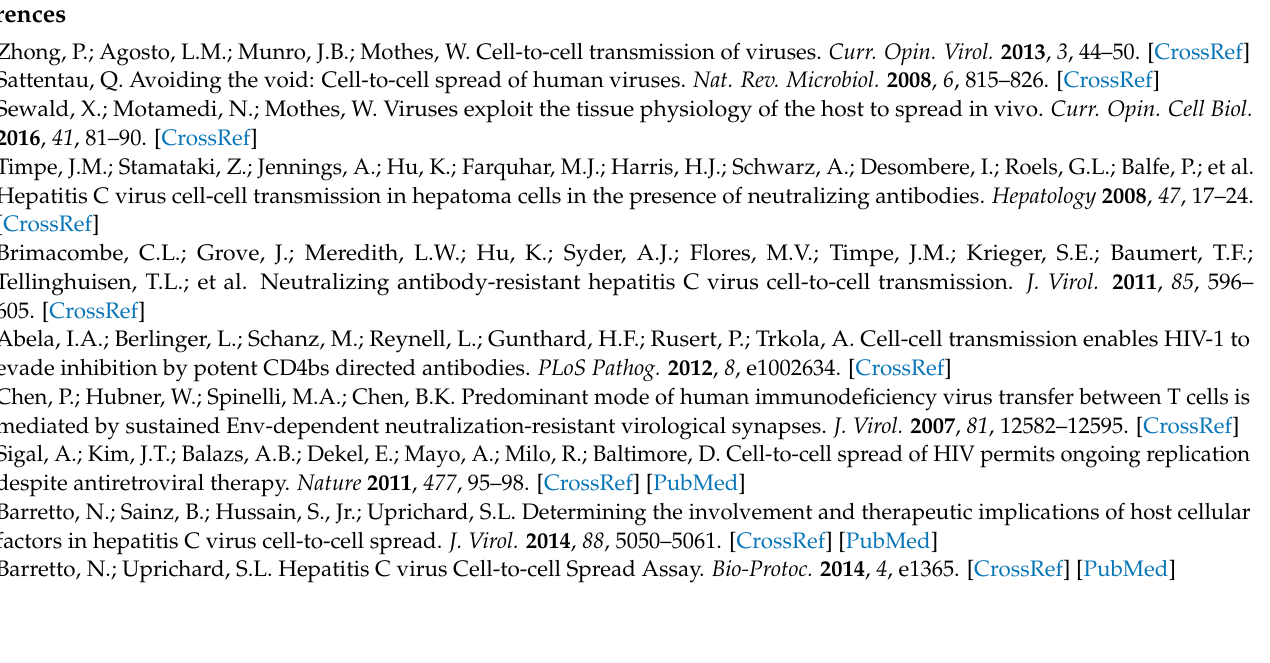
in vitro data, Figure S2: Bimodal HCV foci size distribution, Figure S3: Estimated kernel densities of fitted parameters for simulated data, Figure S4: Model predictions for Exp. B, Figure S5: Estimated kernel densities of fitted parameters to in vitro data obtained from Exp. A, Figure S6: Estimated kernel densities of fitted parameters to in vitro data obtained from Exp. B, Figure S7: Advantages of combined modes of viral spread, and Table S1: Parameter estimates for viral life cycle